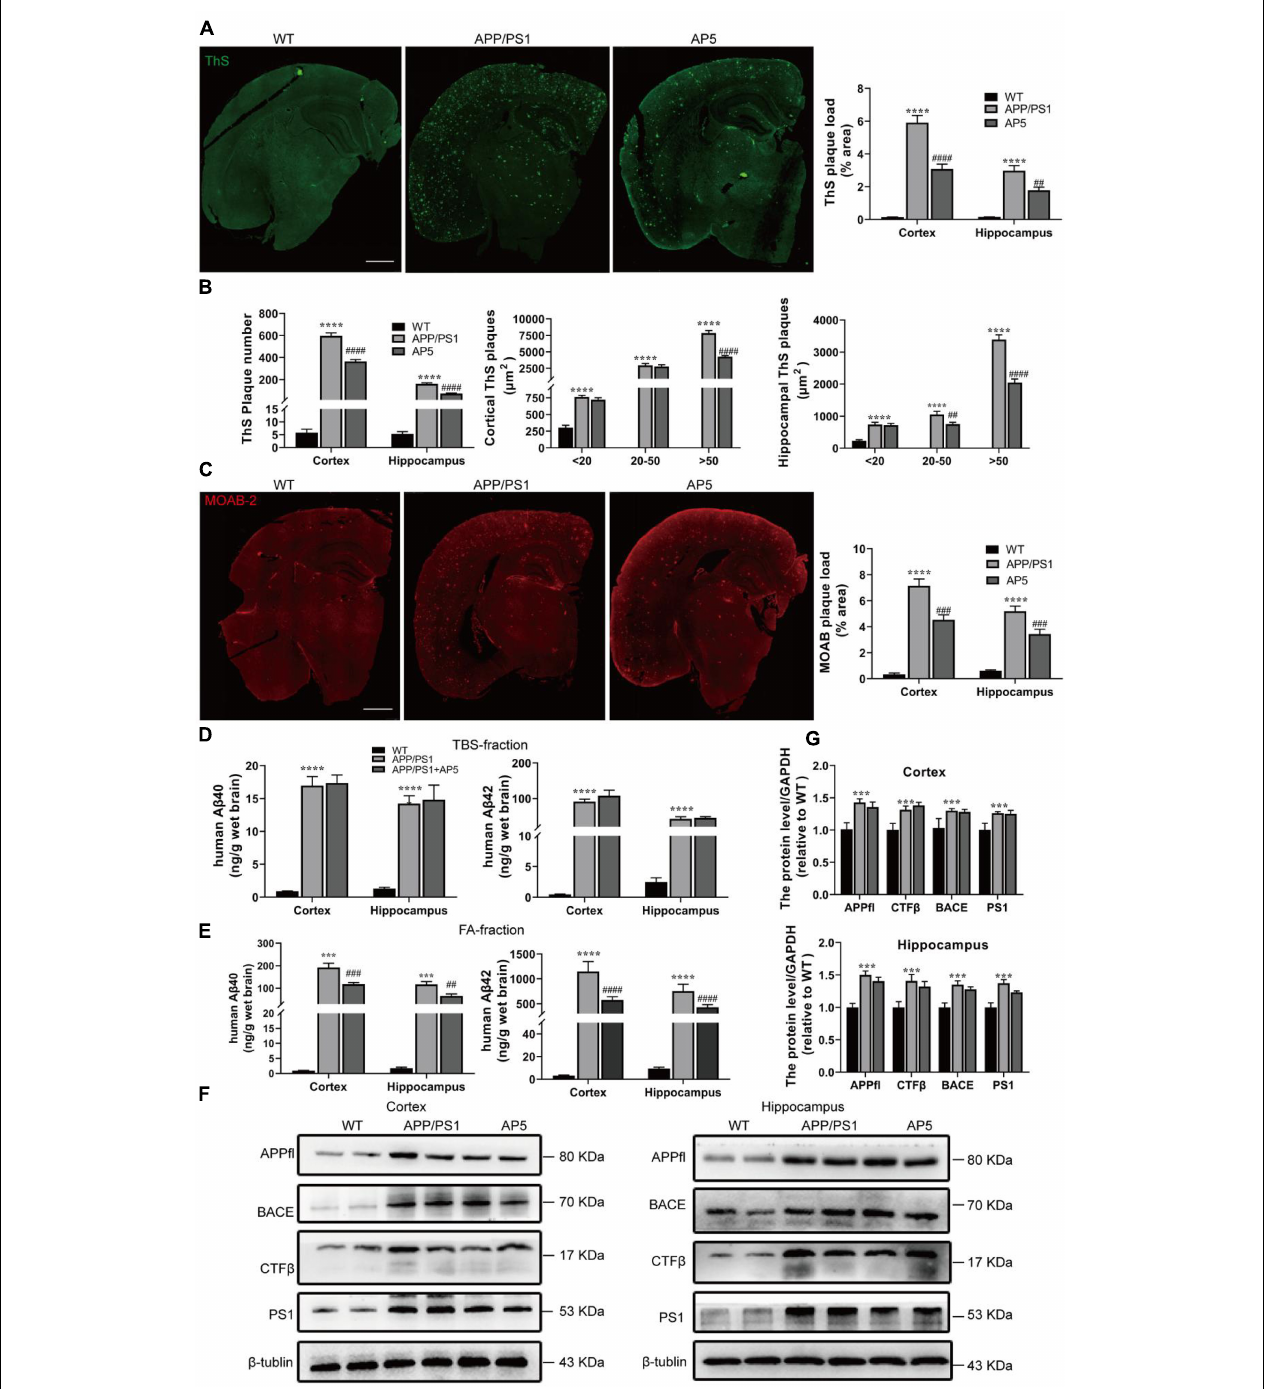
FIGURE 3 | AP5 alleviates A β deposition without influencing APP processing. (A) Representative images and quantification of dense-core amyloid plaque by Thioflavin S (ThS) staining. Scale bar: 500 µ m. (B) Quantification of the number and size of ThS-positive plaques. (C) Representative images and quantification of A β plaque immunofluorescence using MOAB-2 antibody. Scale bar: 500 µ m. (D) The amount of A β 40 and A β 42 in TBS-fractions extracted from the cortex and hippocampus was examined by ELISA analyses. (E) The amount of A β 40 and A β 42 in FA-fractions extracted from the cortex and hippocampus was examined by ELISA analyses. (F) Protein expression of APPfl, CTF β , BACE, and PS1 in the cortex (left) and hippocampus (right) were examined by western blot. (G) Protein expression of APPfl, CTF β , BACE, and PS1 in the cortex (up) and hippocampus (down)were quantified with Quantity One software. *** P < 0.001, **** P < 0.0001 compared with WT mice, ## P < 0.01, ### P < 0.001, #### P < 0.0001 compared with APP/PS1 mice by one-way ANOVA followed by a Turkey’s post hoc test, n = 6 mice per group.